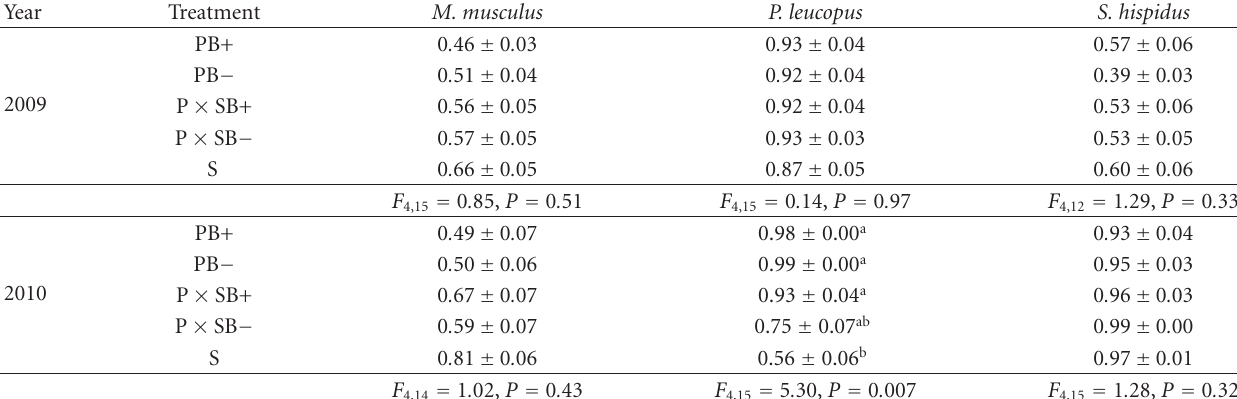
Table 3: Mean ( ± 1SE) survival estimates for intertrapping period intervals by treatment (averaged across time and plots within treatment; calculated in Program MARK). Rodents were captured and released on site at the Lenoir 1 Sustainability Study Site, in Lenoir Co., NC, during 15 July–9 December, 2009 and 19 July–14 November, 2010. Statistical results are from comparisons using a 1-way ANOVA or Kruskal-Wallis test when parametric assumptions were not met. Kruskal-Wallis test statistics are reported as χ 2 estimates. Within a year-species pairing, means with di ff erent letters are significantly di ff erent from one another (Tukey’s post hoc tests). Treatments: PB+ = Pine Biomass+; PB − = Pine Biomass − ; P × SB+ = Pine × Switchgrass Biomass+; P × SB − = Pine × Switchgrass Biomass − ; S =